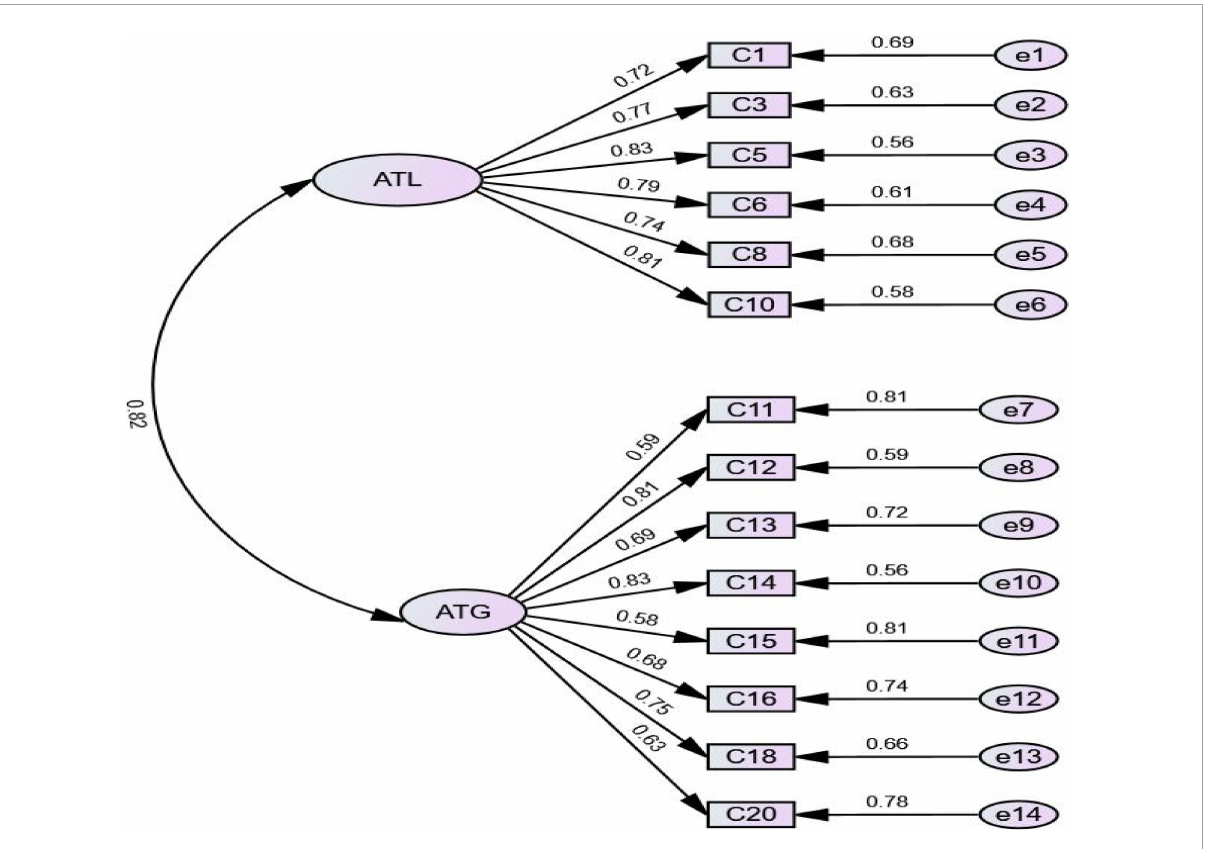
FIGURE2 Confirmatory factor analysis: standardized estimates ( n =